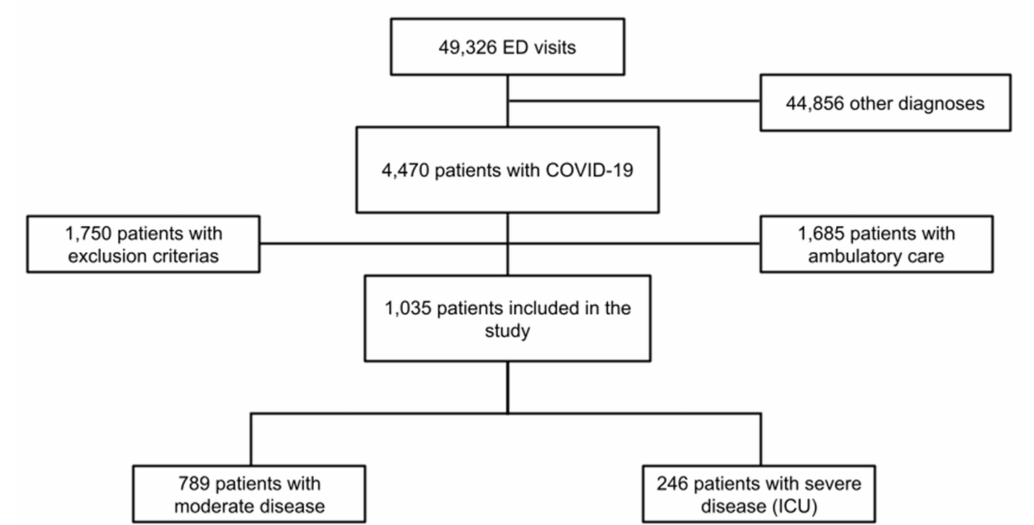
Figure 1. Flowchart of the study.